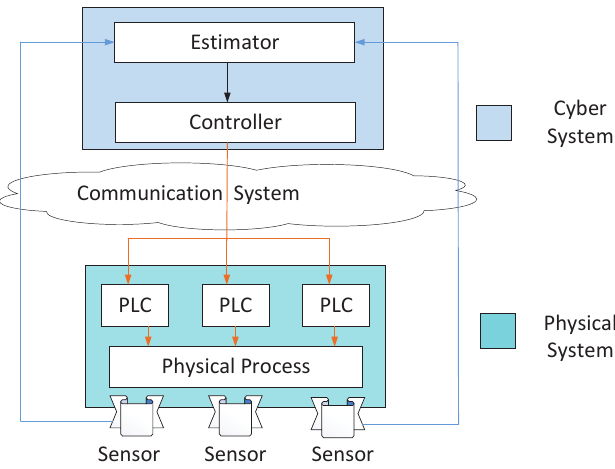
Figure 1. Model of a large-scale cyber-physical system